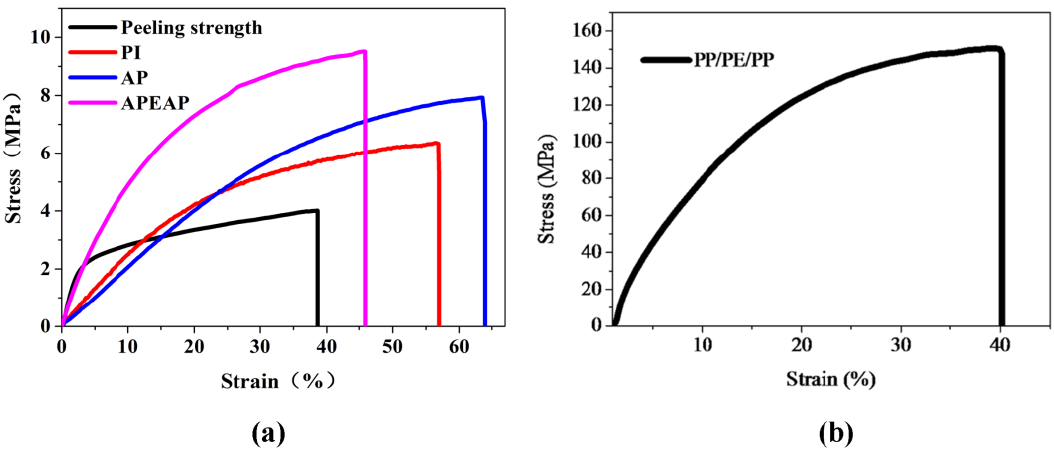
Figure 4. The stress-strain curves of various separators and the adhesion strength between PE and AP membrane: ( a ) The stress-strain curves of PI based separators; ( b ) The stress-strain curve of PP / PE / PP PP/PE/PP separator.